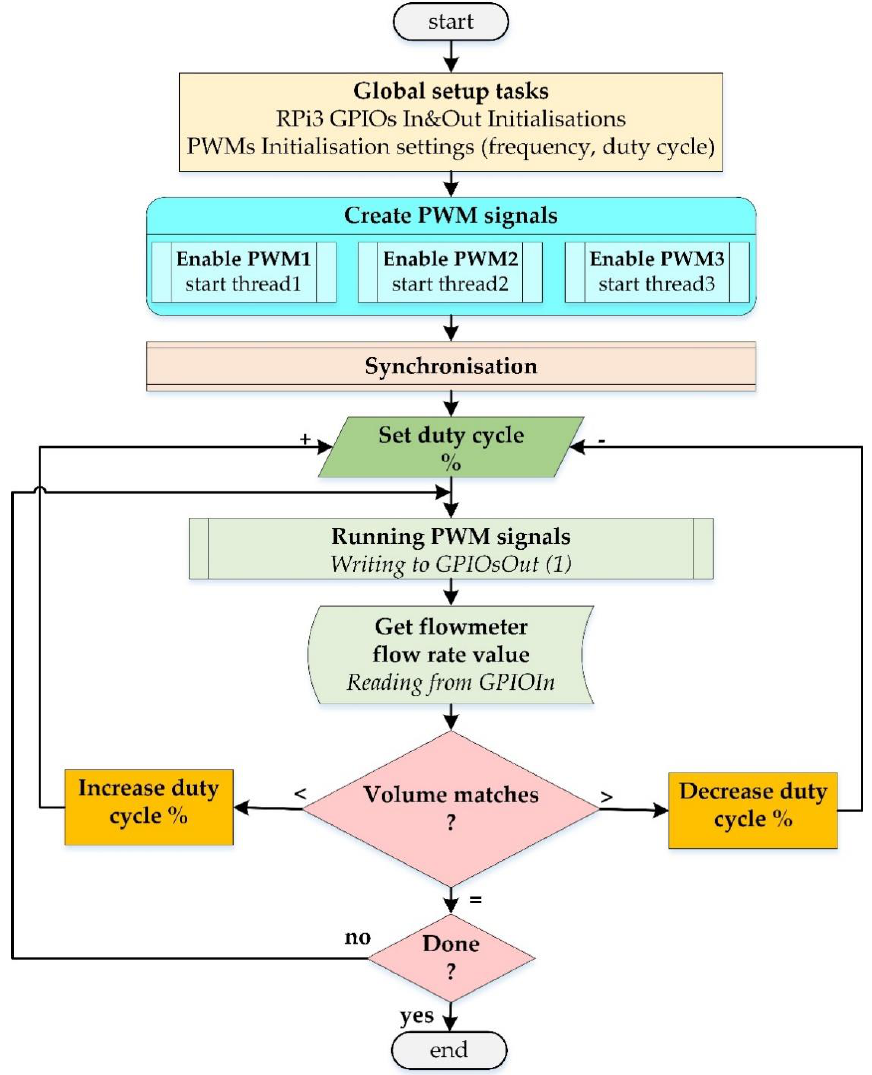
Figure 9. The flowchart of the system control software.